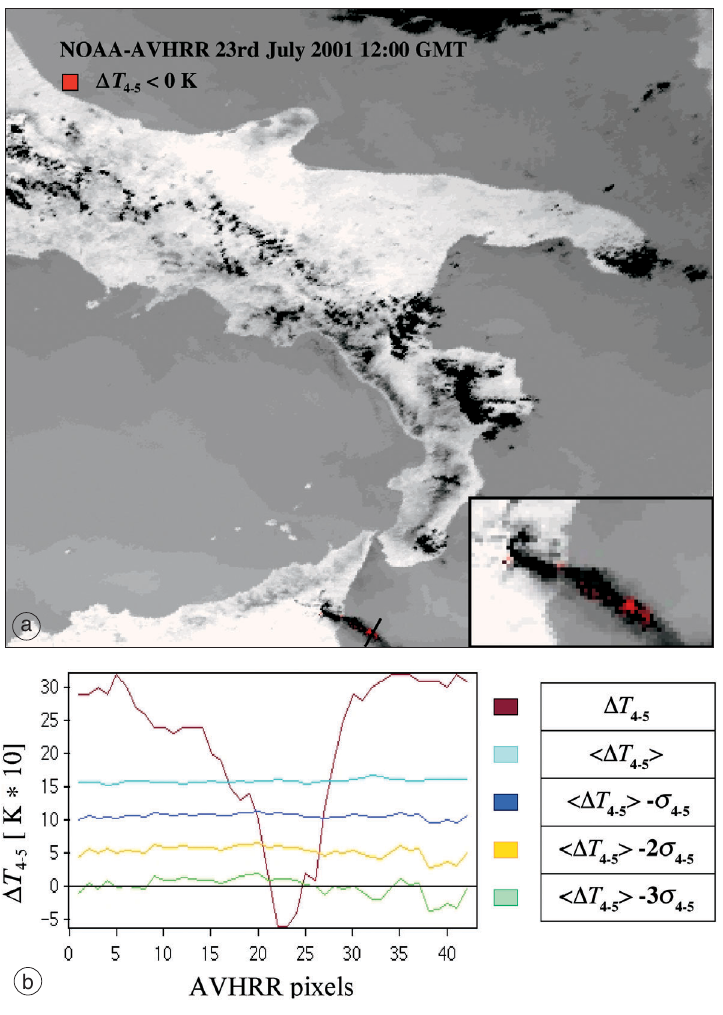
Fig. 1a,b. NOAA/AVHRR July 23rd 2001, 12:00 GMT: a) pixels satisfying Prata’s test, ∆ T 4 − 5 < 0 (see text), are de- picted in red; in background AVHRR channel 4 brightness temperatures are depicted in grey tones (light tones cor- respond to higher BT values). Details of the eruptive plume are given in the box. b) The behaviour of ∆ T 4 − 5 signal across the transect drawn in (a) is plotted together with its reference values corresponding to ⊗ 4 − 5 ( x , y , t ) cuts at